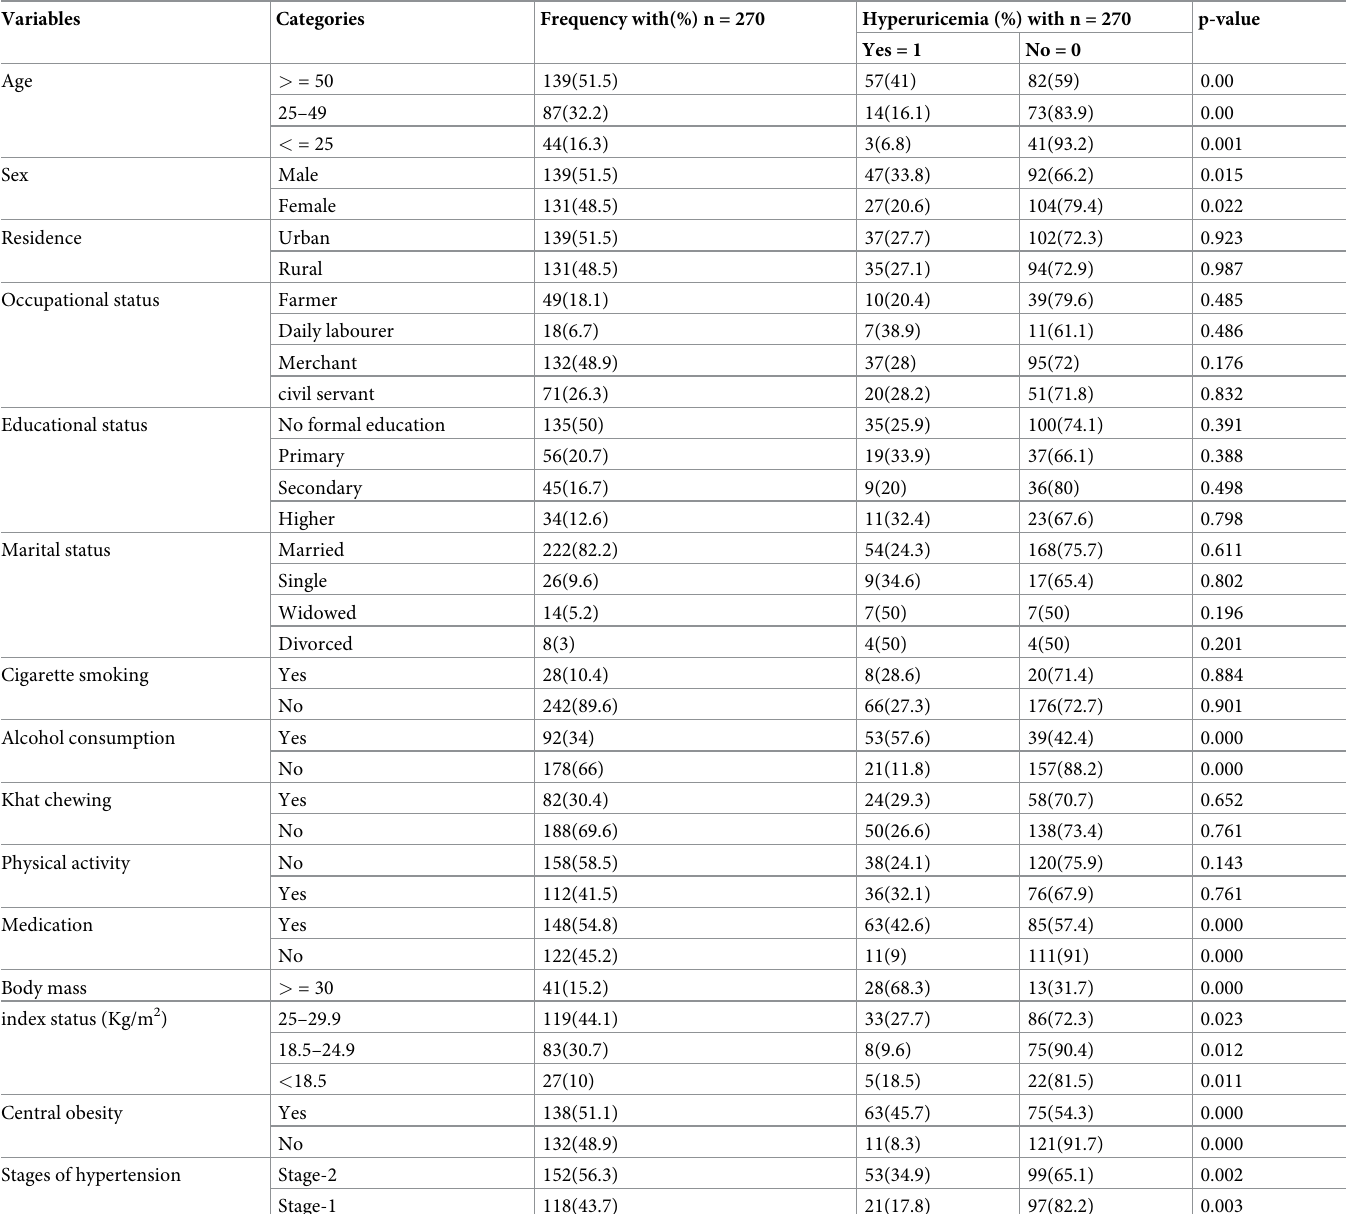
Table 1. Distribution of socio-demographic and clinical characteristics of study